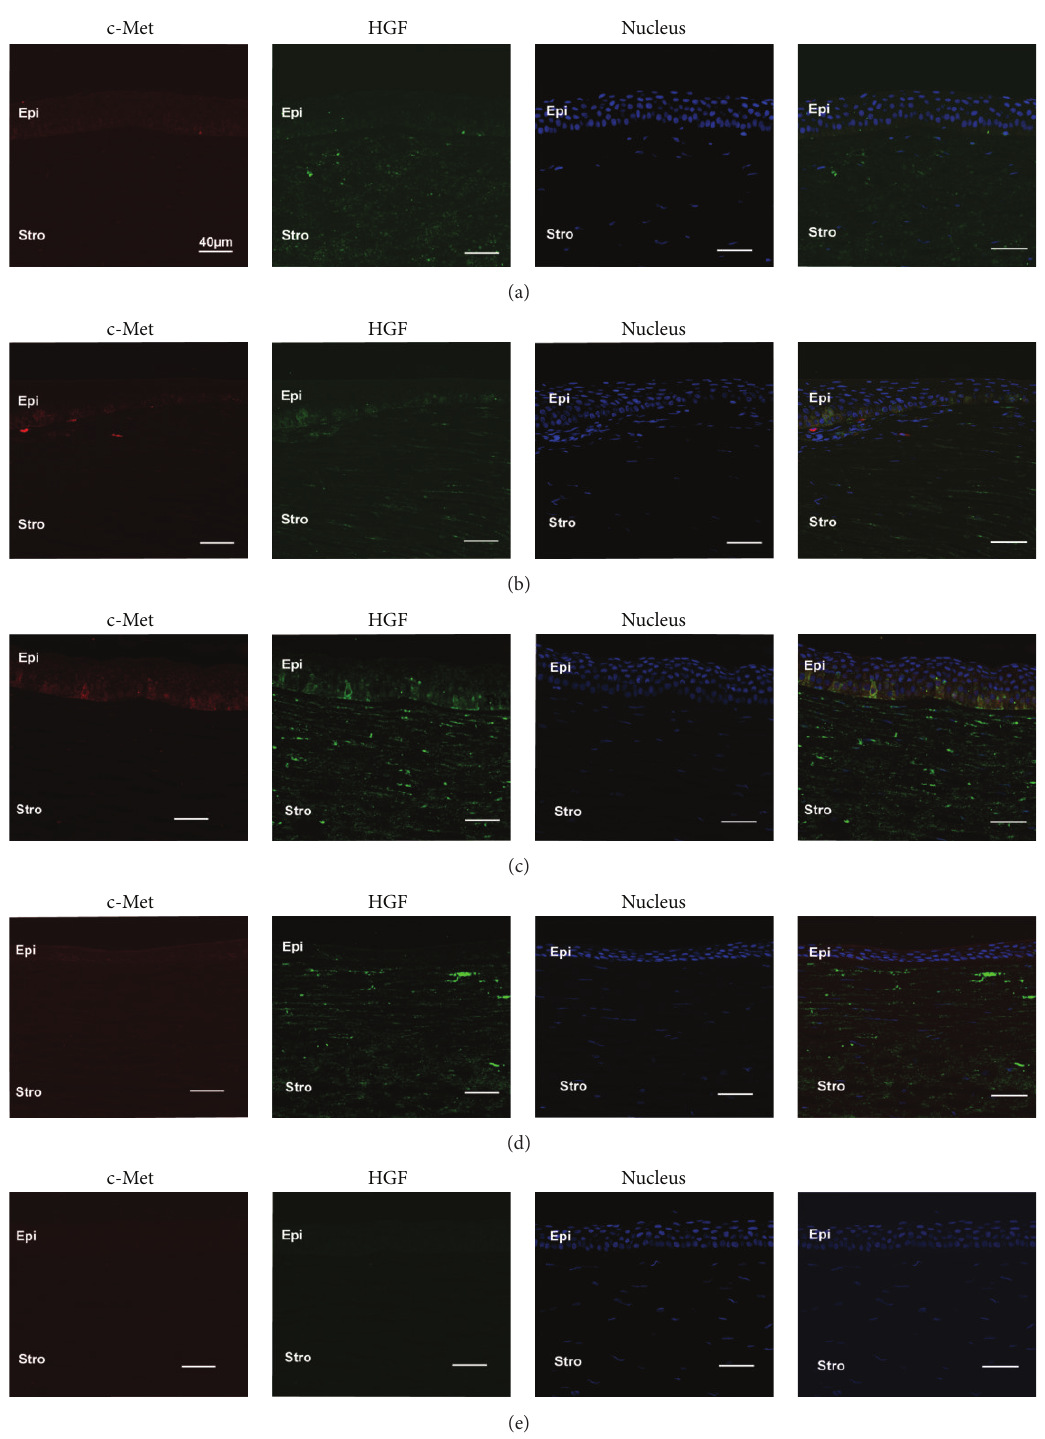
Figure 3: Representative images of central region of corneas with weak, uniform HGF (green), and c-Met (red) expression in all corneal layers (a). Patchy staining of HGF and c-Met is colocalised in the basal epithelium of both limbal regions (b) and adjacent to cone region of KC (c), with KC showing stronger staining than the limbal region. Strong HGF expression is seen within the stroma of both KC (c and d) and control corneas (a and b). (a) Central region of control cornea, (b) limbal region of control cornea, (c) region adjacent to the cone in KC cornea, (d) cone region in KC cornea, and (e) Ms and Rb Ig control